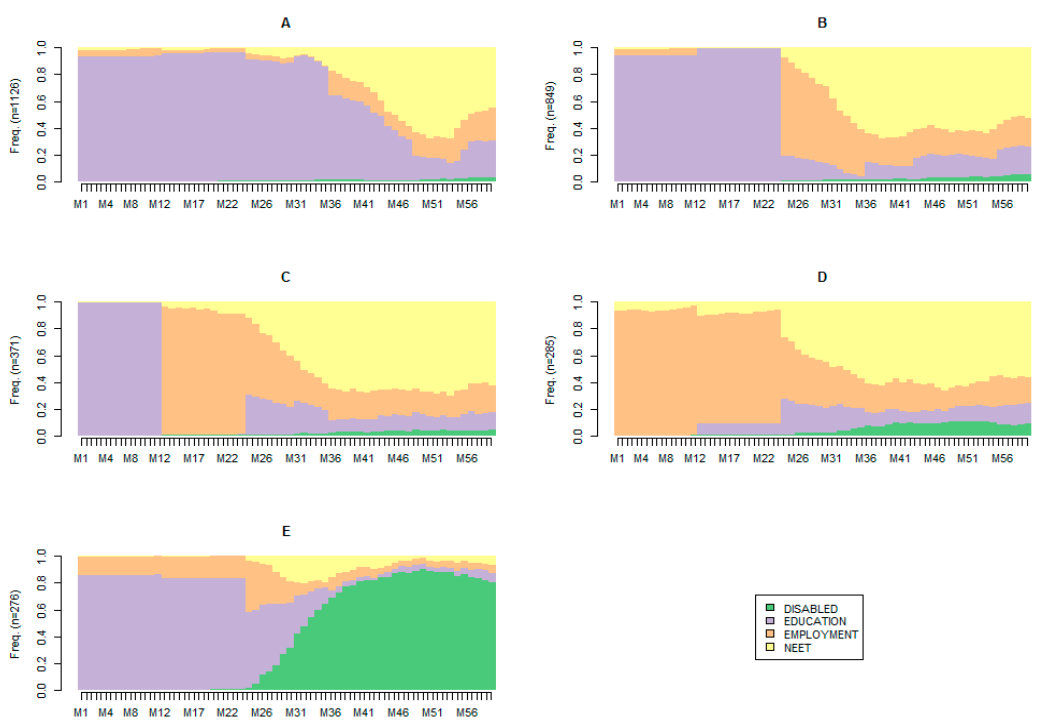
Figure 2. Cross-sectional distributions by cluster; young adults aged 16–20 with a minimum of six months not in employment or education. Note: purple = education; orange = employment; yellow = NEET; green = disability pension.